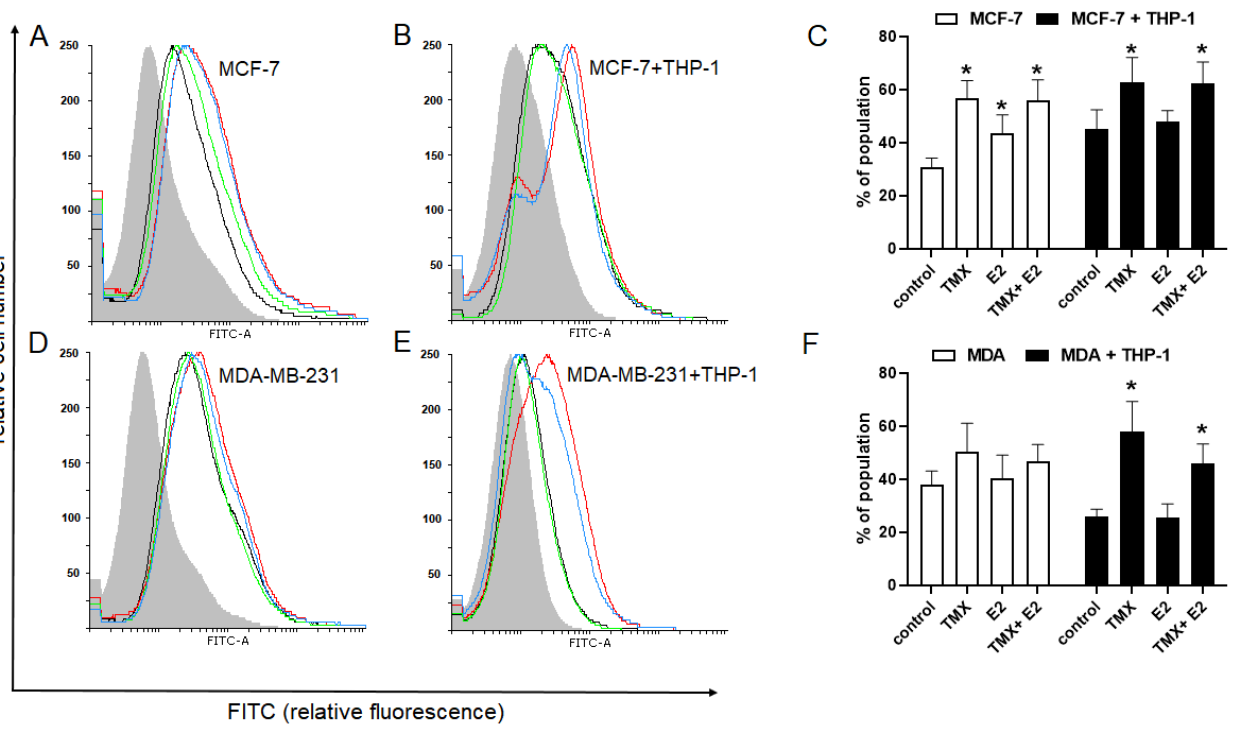
Figure 5. Effect of TMX and/or E2 on the binding of Siglec-5/Fc fusion protein to MCF-7 ( A , B ) and MDA-MB-231 ( D , E ) breast cancer cells grown in monocultures or co-cultures. Representative histograms and the corresponding bar graphs ( C , F ) show the isotype of the control (light grey filled histogram), the control cells (black line), TMX-treated cells (red line), E2-treated cells (green line) and cells concomitantly treated with TMX/E2 (blue line). Data are presented as the median percentage of each population (mean of 5 separate determinations). * p < 0.05 vs. the corresponding control group.